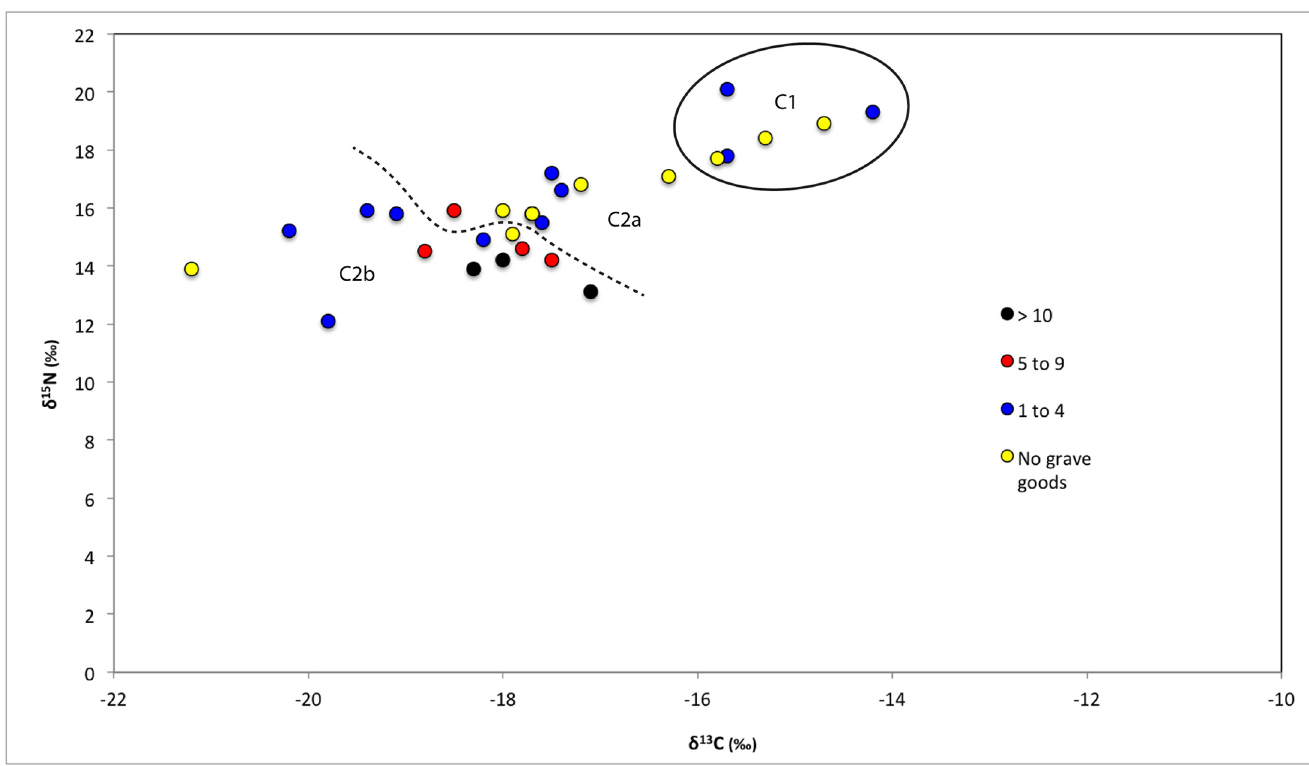
Fig 6. Human bone collagen δ 15 N and δ 13 C values from Wairau Bar coded with grave goods information.